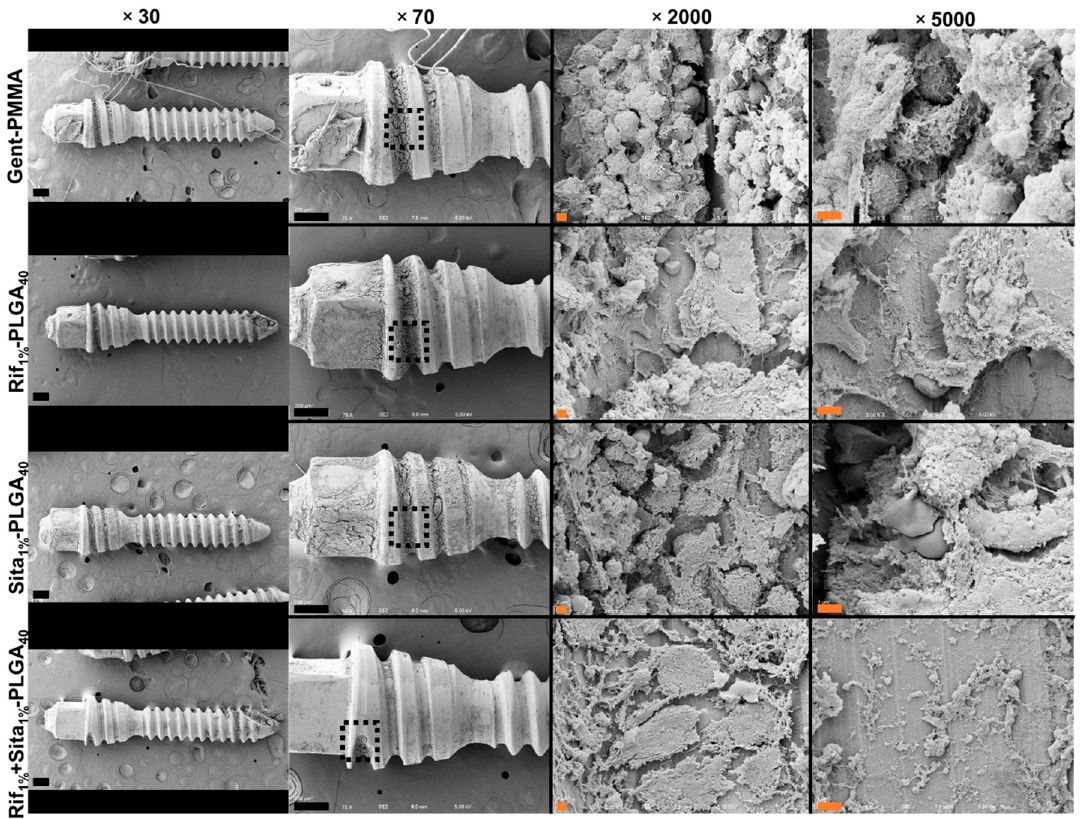
Figure 7. Representative scanning electron microscopy (SEM) of harvested hardware after 10 weeks post-revision surgery. Titanium screws were harvested 10 weeks post-revision surgery to qualitatively investigate biofilm formation and the presence of Staphylococcus aureus colonization between groups. Representative images are shown at magnifications of 30×, 70×, 2000× and 5000×. No structures consistent with 1 µ m diameter of S. aureus cocci were observed in any of the four groups. Black scale bars indicate 200 µm and orange scale bars indicate 2 µm.